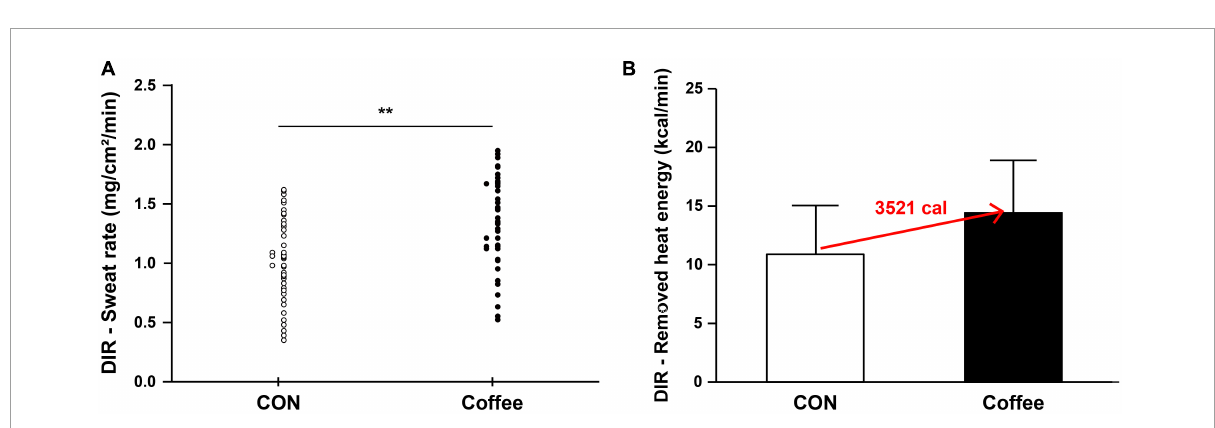
FIGURE3 (A) Comparison of sweating activity of subjects in CON and Coffee groups showing direct activation (DIR) of sweat response. (B) Comparison of estimated value on remove heat energy of whole body between CON and Coffee groups. Values are means + SD. Statistical significance difference, ** p < 0.01. CON, no coffee group ( n = 40); Coffee, coffee intake group ( n = 40); DIR, directly activated